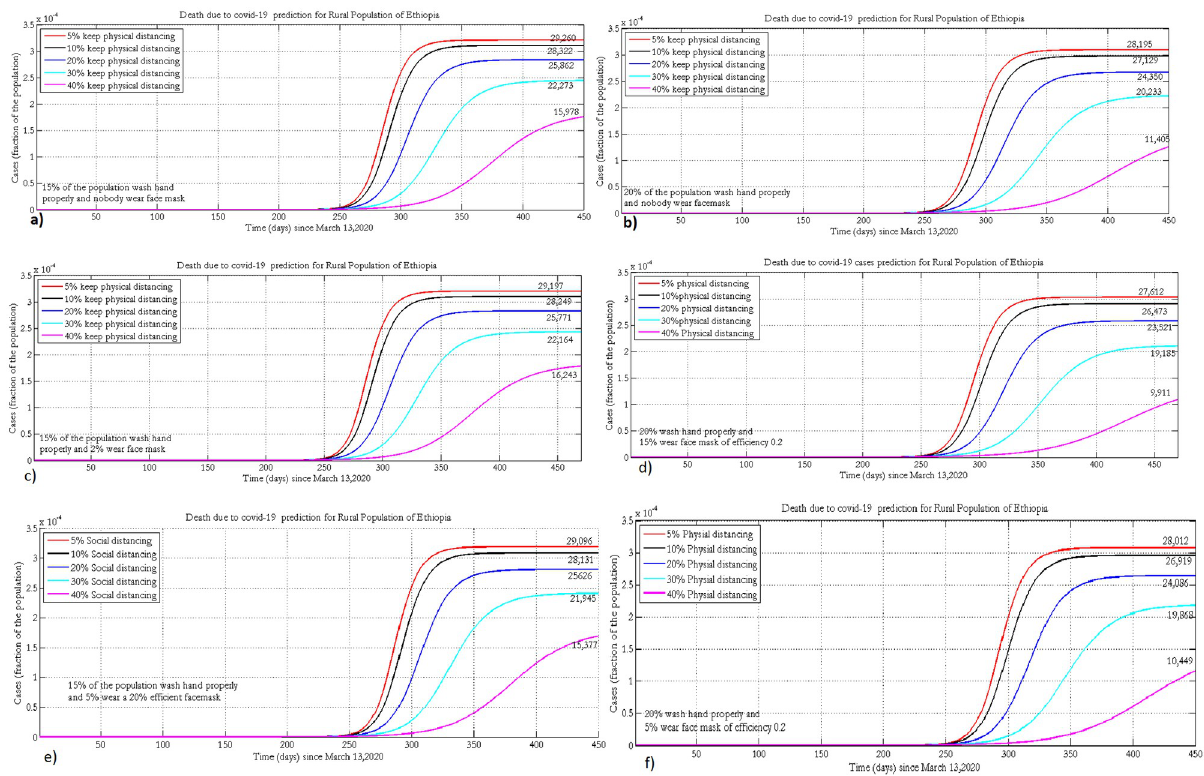
Fig 9. Projected number of cumulative death due to COVID-19 in rural Ethiopia when 15% or 20% practice hand washing and 0% (a, b), 2% (c, d) or 5% (e, f) of the population wear face masks, with 20% efficacy.